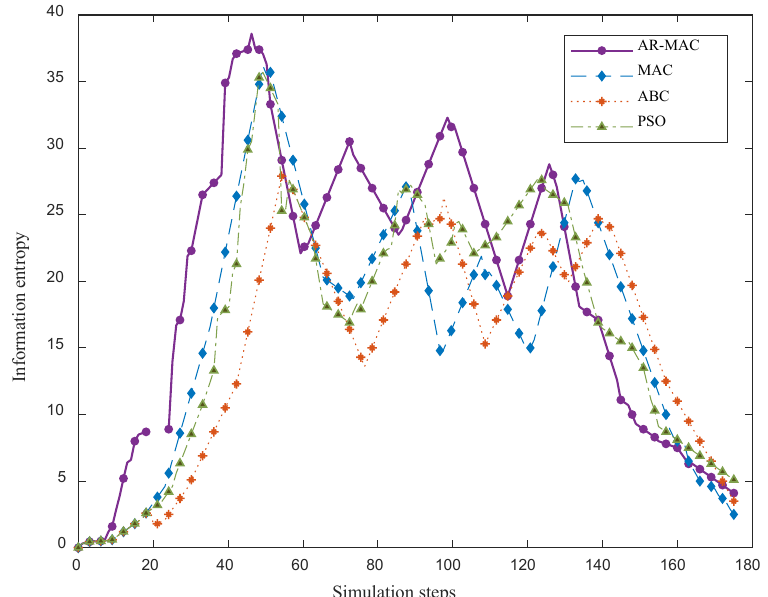
Figure 7. Target-discovery benefits under two scenarios with the same algorithm.